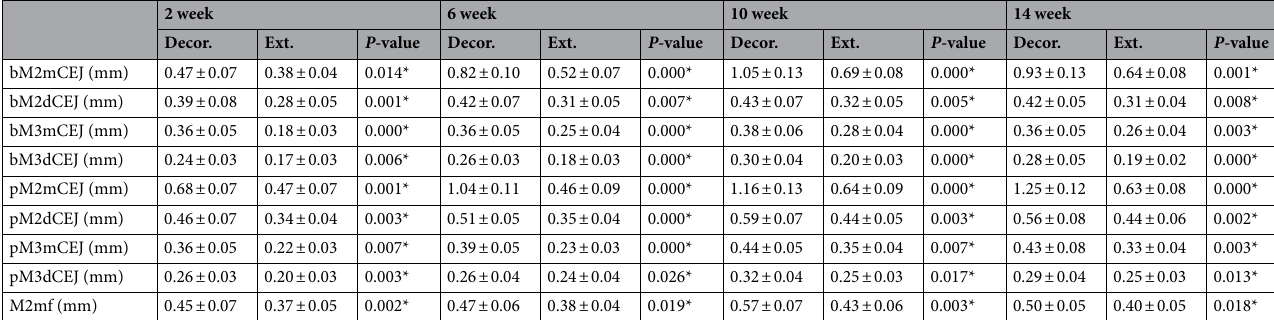
Table 2. Micro-computed tomography assessments of the distances from marginal bone to cemento-enamel junction (CEJ) at buccal (b), palatal (p), mesial (m), and distal (d) aspects of maxillary second molar (M2) and third molar (M3) and the distance from CEJ to mesial furcation of M2 (M2mf) comparing the decoronation (Decor.) and contralateral extraction (Ext.) sides at 2, 6, 10, and 14 weeks. n = 6 per group; Statistically significantly different at * P < 0.05; Data are represented as mean ± standard deviation.